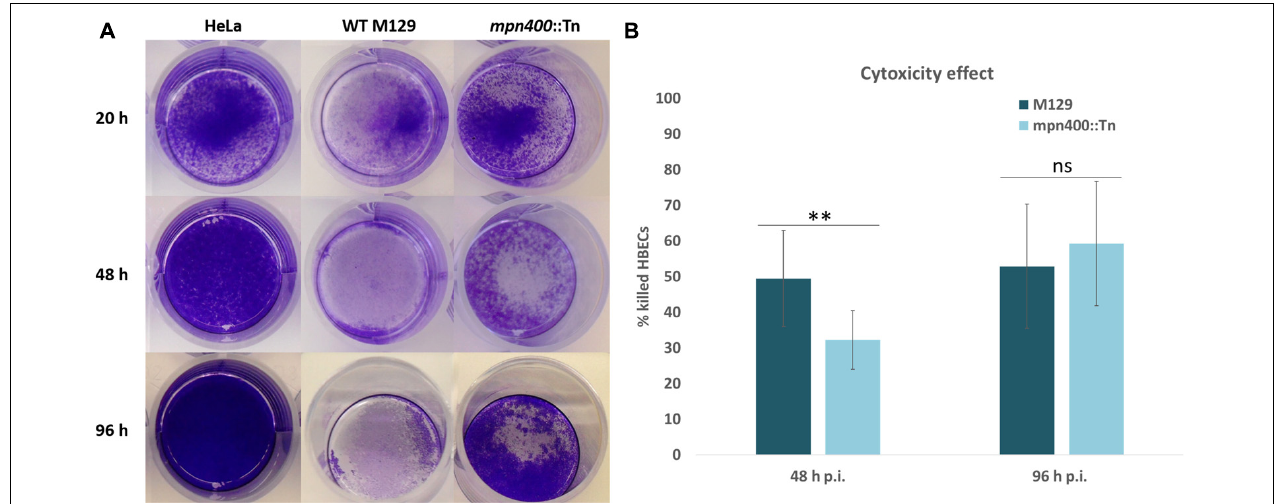
FIGURE 4 | Crystal violet stain of HeLa cells after mycoplasmal infection. Cytotoxicity of M. pneumoniae strains toward HeLa cell cultures. Confluent HeLa cell culture without infection or with M129 wild type cells and with GPM113 ( mpn400 :Tn) mutant cells. (A) After 20 h, 48 h, and 96 h post infection HeLa cells were stained with crystal violet and photographed. (B) OD 595 measurements were plotted and statistical significance of the cytotoxicities in different strains at the two time points was calculated. For the original data, see Supplementary Data Sheet S1 .